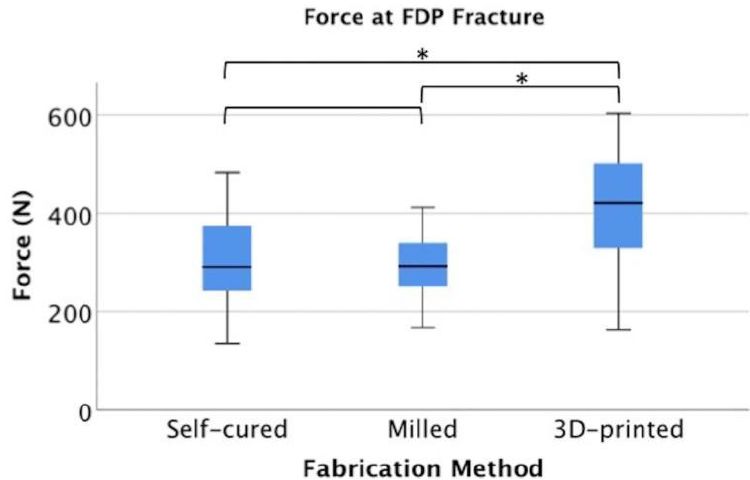
Figure 3. Force at fracture for self-cured PMMA, milled PMMA and 3D-printed resin experimental sets. (N = 15) Shapiro-Wilk was used to test for normality. ANOVA and Tukey post-hoc tests were used to compare experimental groups at significance level 0.05. Asterisk (*) indicates a significant difference.